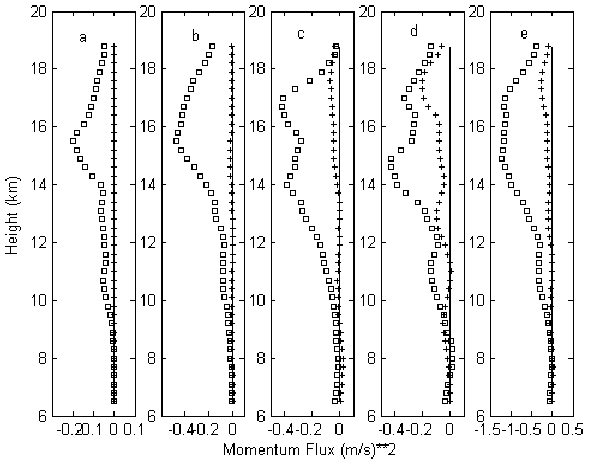
Fig. 3. 72h averaged profiles of zonal- (square) and meridional- Fig.3 72 hours averaged profiles of zonal- (square) and meridional- (cross) momentum (cross) momentum fluxes for periods of (a) 10–30min, (b) 30min– fluxes for periods of (a) 10- 30 min, (b) 30 min– 2 h, (c) 2- 7 h, (d) 7- 24 h, and (e) 10 2h, (c) 2–7h, (d) 7–24h, and (e) 10min–24h. The vertical straight lines are reference lines for zero momentum flux. min- 24 h. The vertical straight lines are reference lines for zero momentum flux.